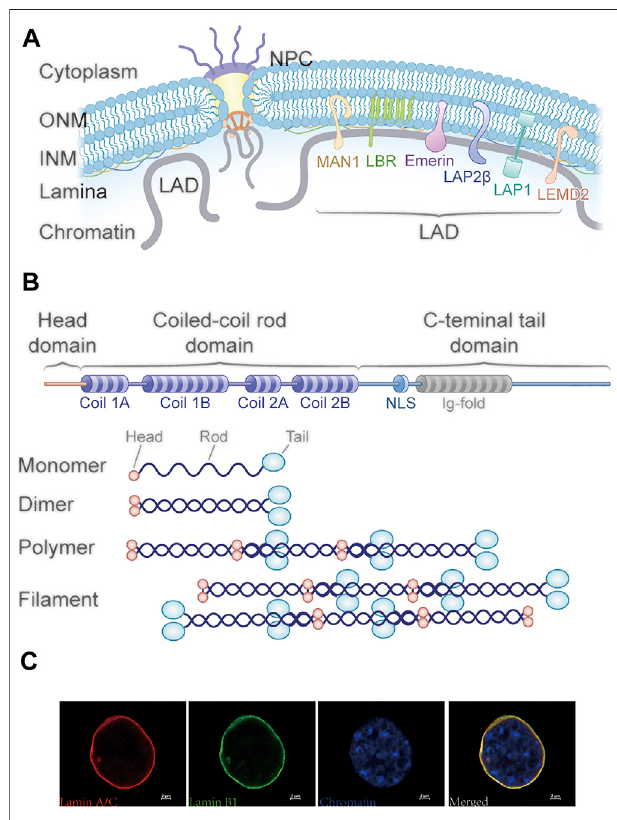
FIGURE1| Structureofthenuclearperipheryandlamins. (A) Schematic representation of the nuclear envelope structure. The nuclear lamina lies beneath the inner nuclear membrane and interacts with nuclear proteins and chromatin at lamina-associated domains (LADs). Several nuclear lamina proteins, including lamin A/C, B1, B2, lamin B receptor (LBR),and emerin, are associated with LAD positioning. (B) Schematic structure of lamins. The lamins consist of three domains including an N-terminal head domain, a central coiled-coil rod domain, and a globular C-terminal tail domain with the NLS and Ig-fold. Lamins assemble into higher order fi laments through rod domain interactions. Lamin dimers form head-to-tail polymers and then assemble into fi laments in an antiparallel manner. (C) Immuno fl uorescence images ofmouse collecting duct cells stained for lamin A/C (red) and lamin B1 (green) and DNA